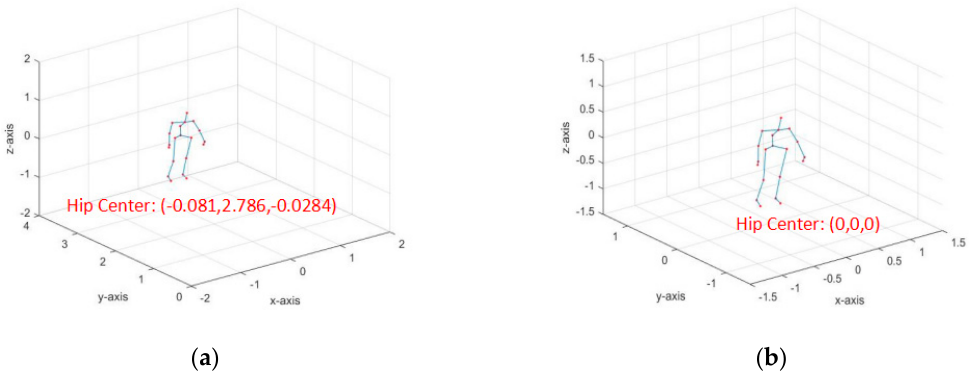
Figure 2. Comparisons of the skeleton before and after preprocessing: ( a ) Before preprocessing; ( b ) After preprocessing.